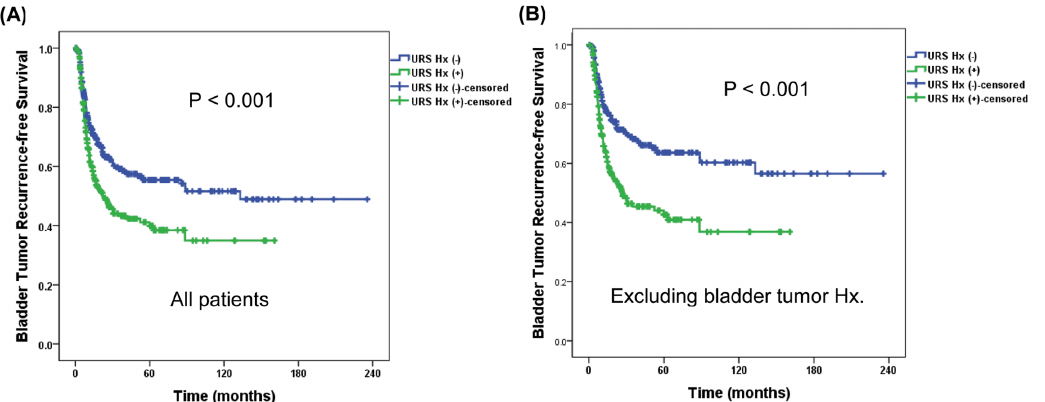
Fig 2. Survival analysis of intravesical recurrence according to preoperative ureterorenoscopy in all patients (A, n = 630) and excluding prior bladder tumor history (B, n = 507) following radical